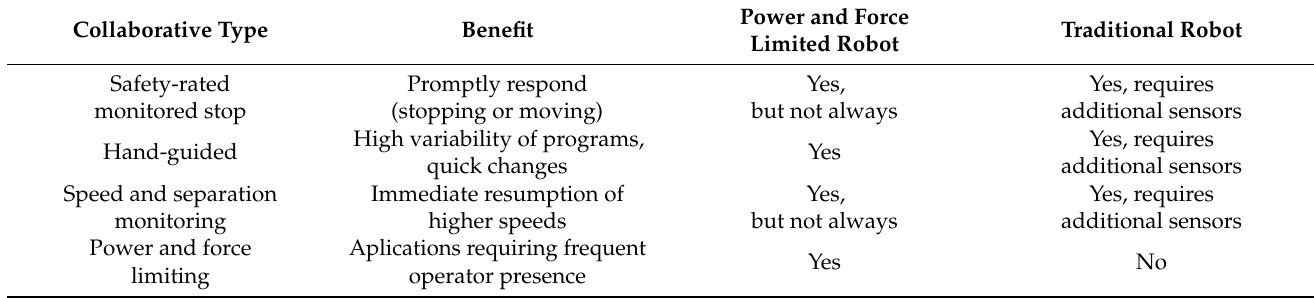
Table 2. Summary of collaborative industrial robotic systems